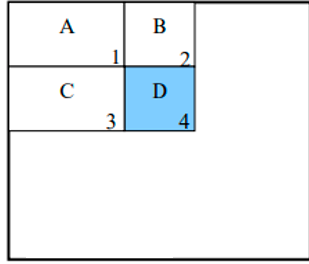
Figure 7. Schematic diagram of the calculation of the Haar-like feature by using the integral image.